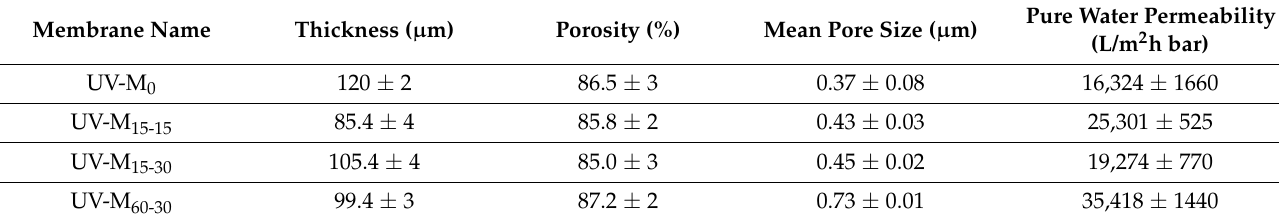
Table 2. Features of the membranes